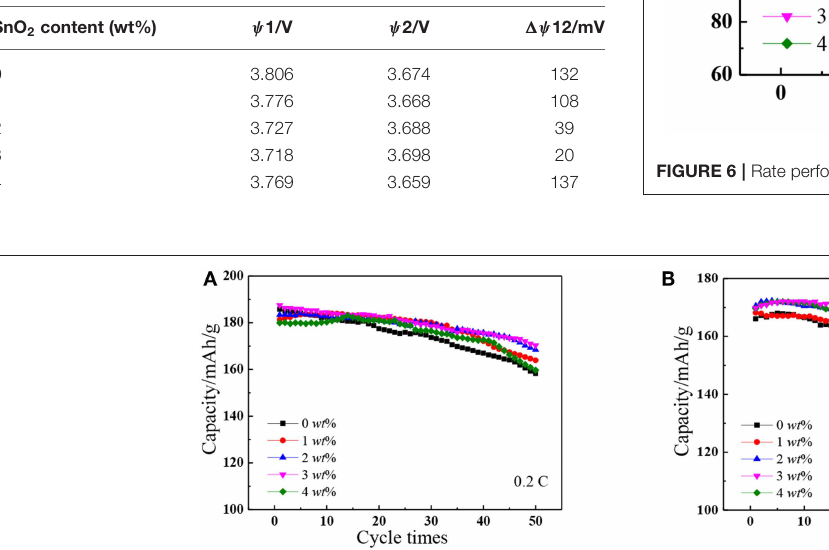
TABLE 1 | Values of CV peaks for pristine and SnO 2 -modified materials in the third cycle.